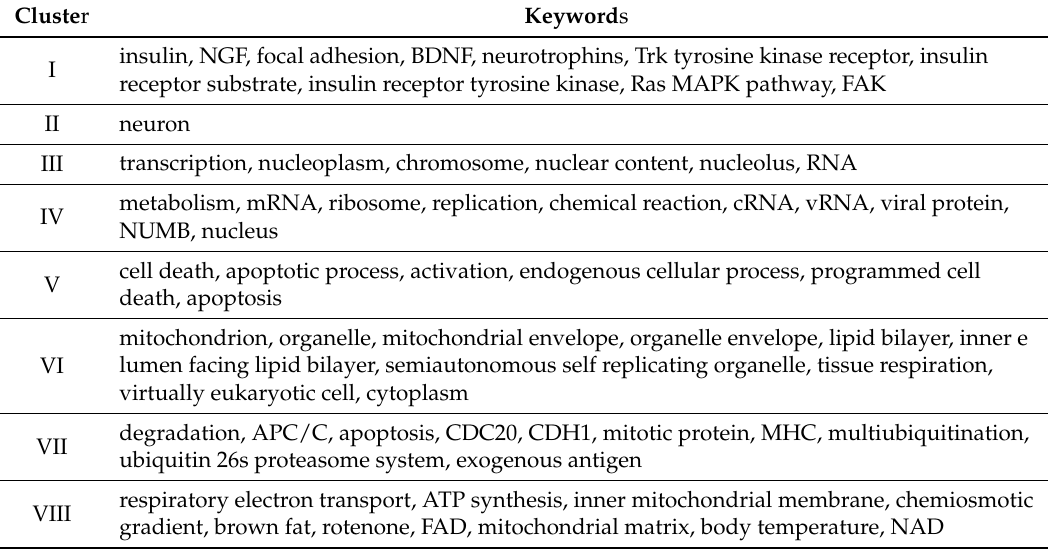
Table 1. Ten significant keywords with q-value < 0.05 in each pathway